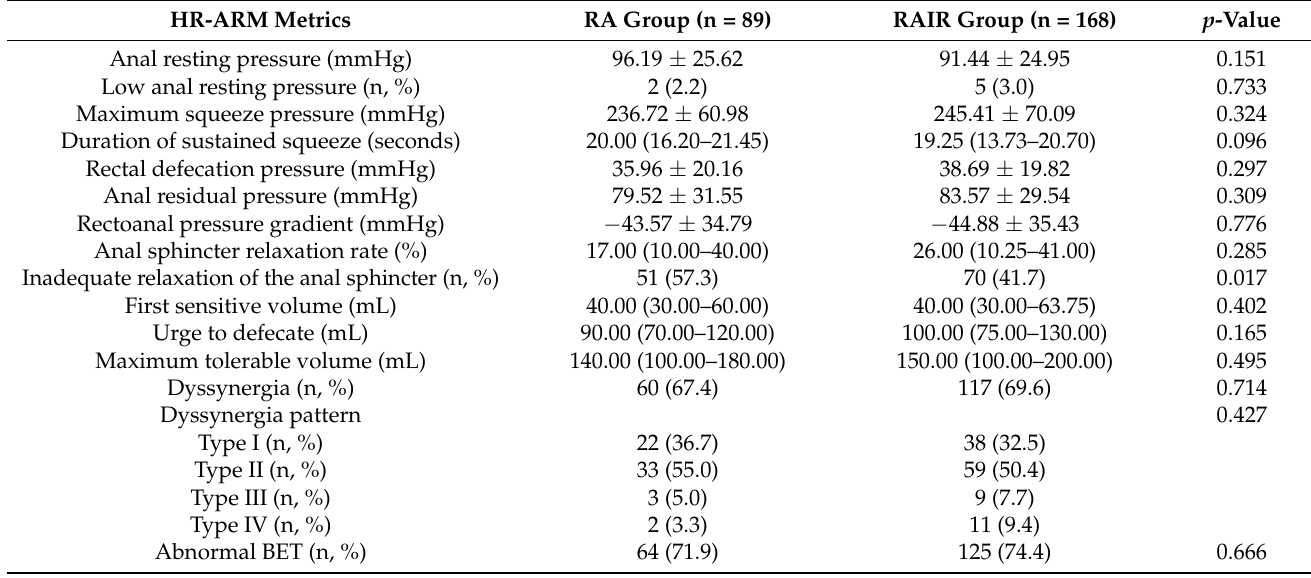
Table 3. Manometric parameters.